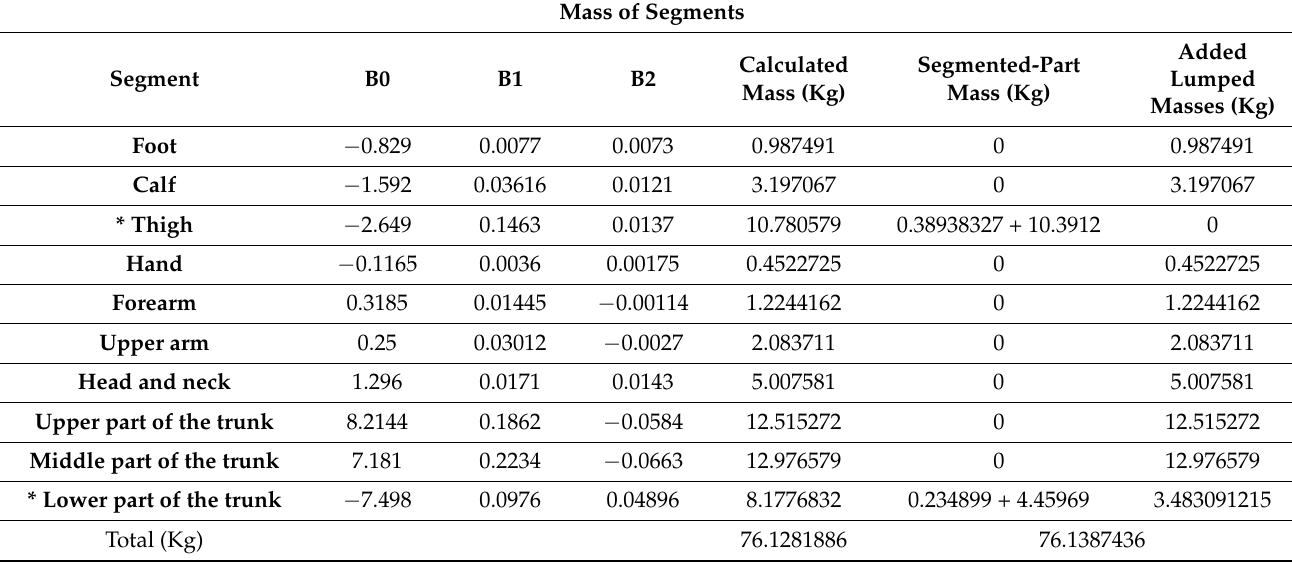
Table A2. Stiffness and damping coefficients for spring [47] and damper [48].